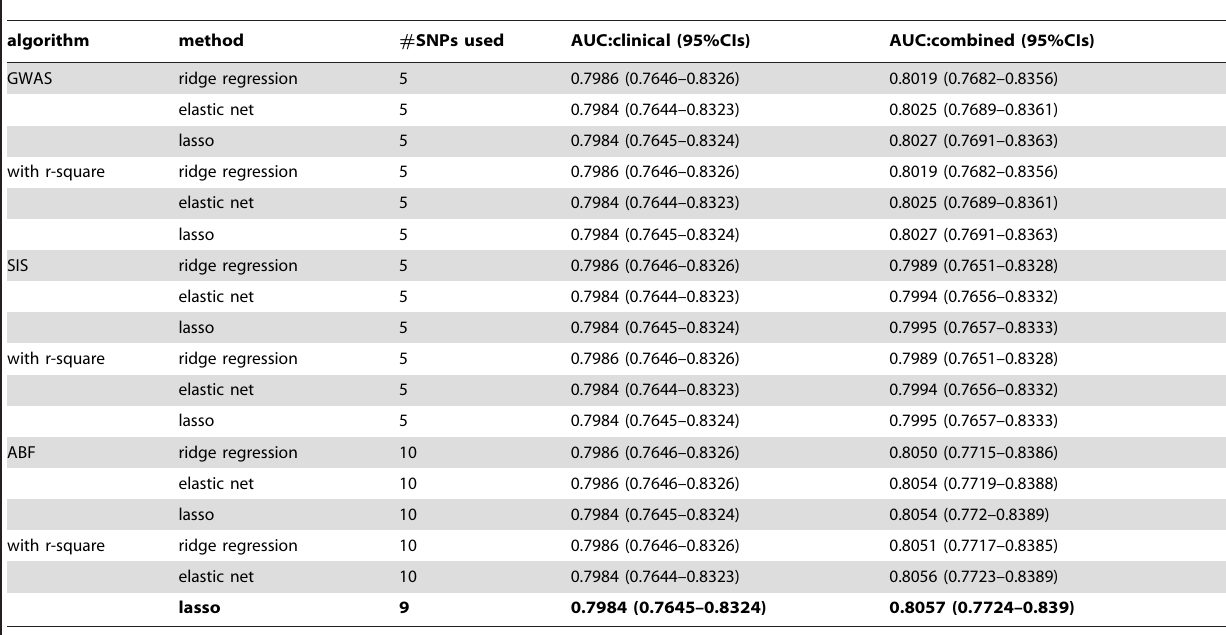
Table 1. The top AUCs observed in regression methods and the number of SNPs used in risk prediction model construction.